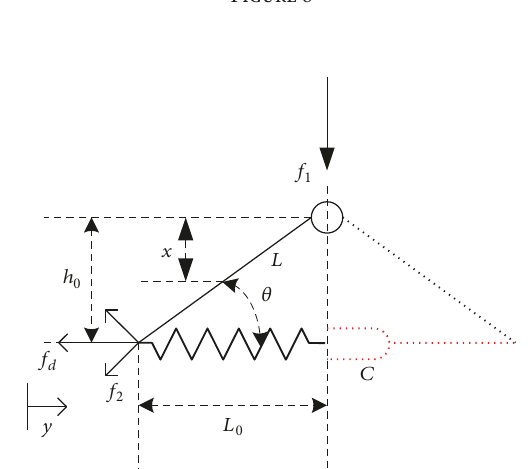
Figure 9: Schematic diagram of the damping force transmission